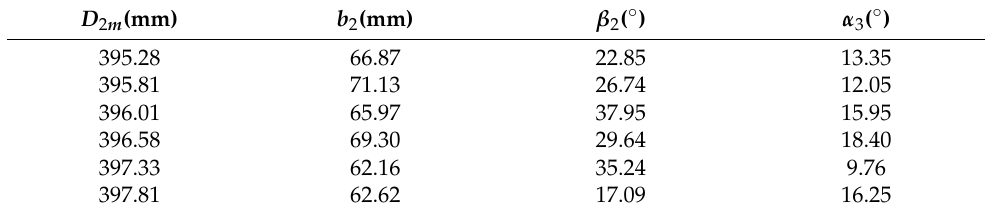
Table A1. Design variable samples generated by the OLHS